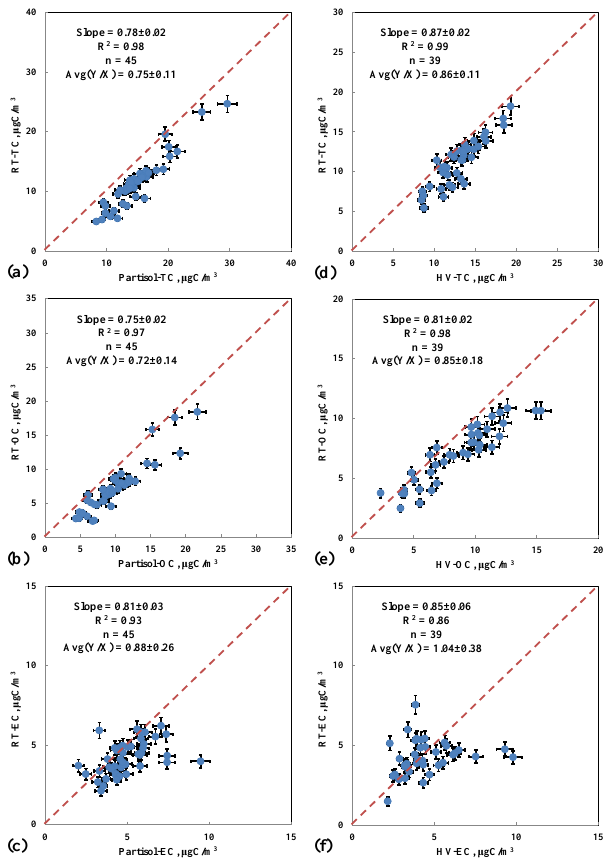
Figure 1 . Scatter plots of semi-continuous measurements versus filter-based chemical data Figure 1. Scatter plots of semicontinuous measurements versus for PM 2.5 samples collected at MK AQMS during May 2011–April 2012. (a) RT-TC vs. filter-based chemical data for PM 2 . 5 samples collected at MK Partisol-TC by TOT; (b) RT-OC vs. Partisol-OC by TOT; (c) RT-EC vs. Partisol-EC by TOT; AQMS during May 2011–April 2012. (a) RT-TC vs. Partisol-TC by thermal–optical transmittance (TOT) method, (b) RT-OC vs. (d) RT-TC vs. HV-TC by TOT; (e) RT-OC vs. HV-OC by TOT and (f) RT-EC vs. HV-EC by Partisol-OC by TOT, (c) RT-EC vs. Partisol-EC by TOT, (d) RT-TC TOT. vs. HV-TC by TOT, (e) RT-OC vs. HV-OC by TOT and (f) RT-EC vs. HV-EC by